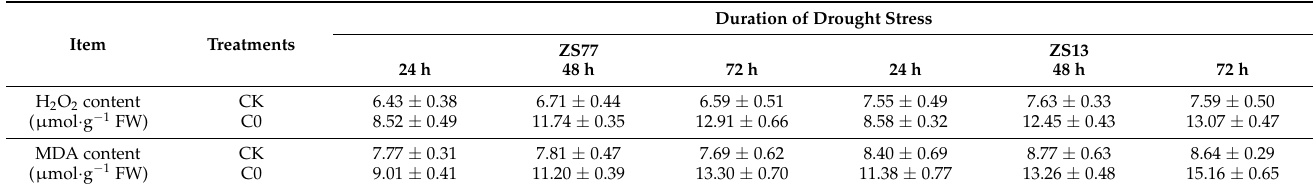
Table 3. Effects of drought stress on H 2 O 2 , MDA contents in sweet potato